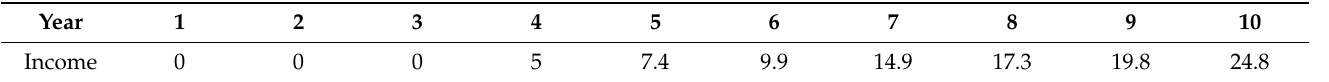
Table 6. The income of navel oranges over 10 years (CNY